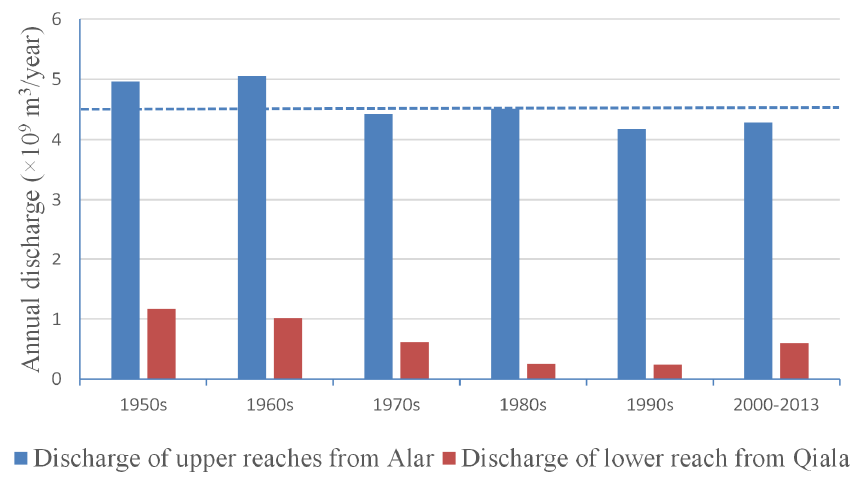
Figure 2. Annual discharge of the main stem Tarim River in the past six